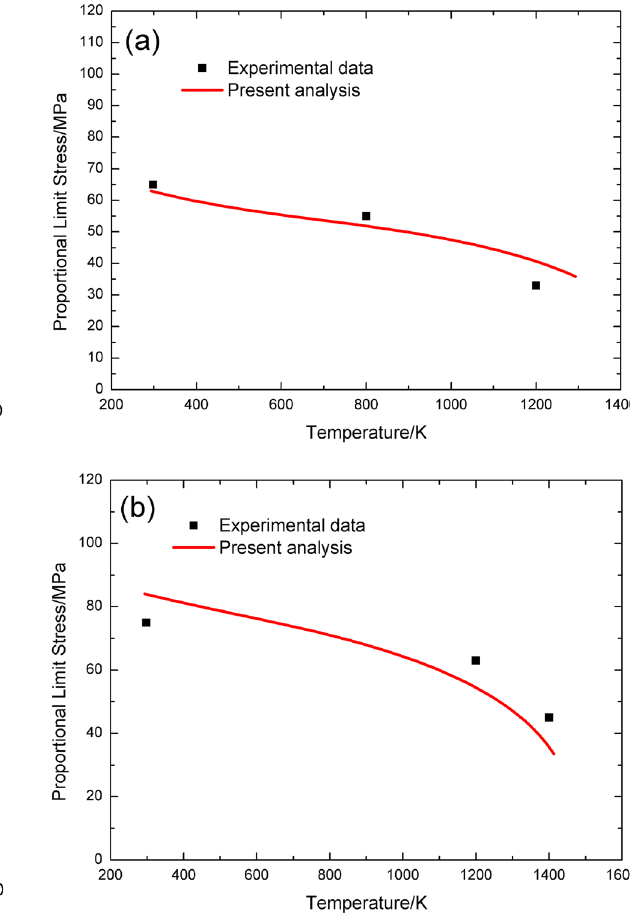
Figure 8: Experimental and predicted PLS versus the temperature curves of ( a ) SiC/SiC composite with the PyC interphase and ( b ) SiC/SiC composite with the BN